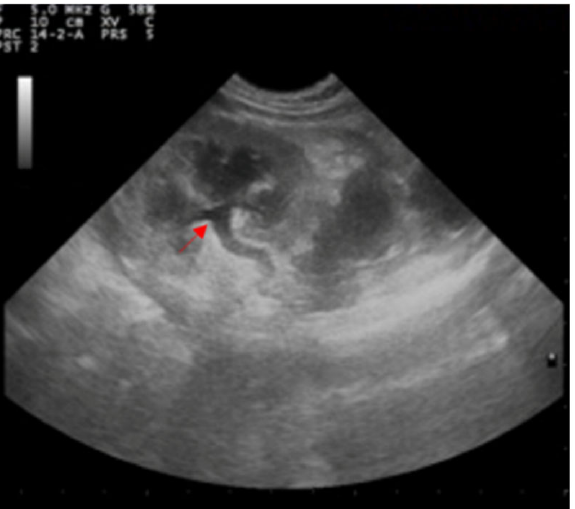
Figure 3. Ultrasound examination of the left kidney showing the dilatation of the renal pelvis and ureter (red arrow).